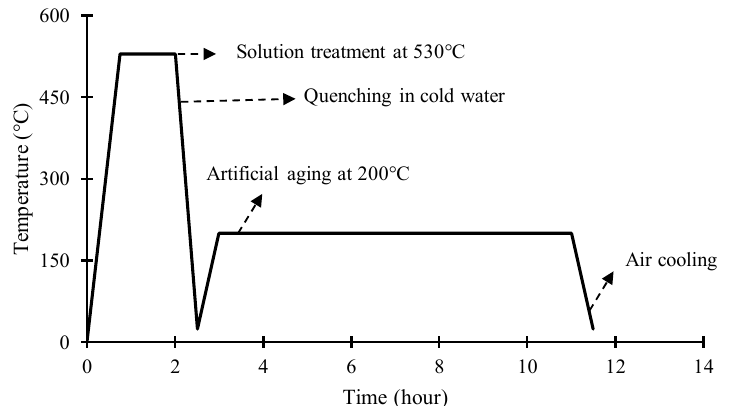
Figure 3. The STA treatment performed on FSW joints.